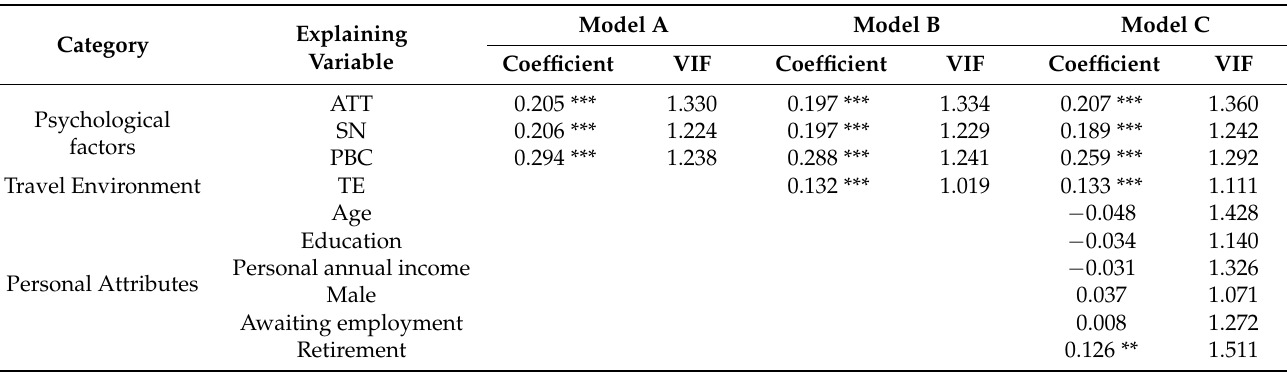
Table 8. Verification of effective influencing